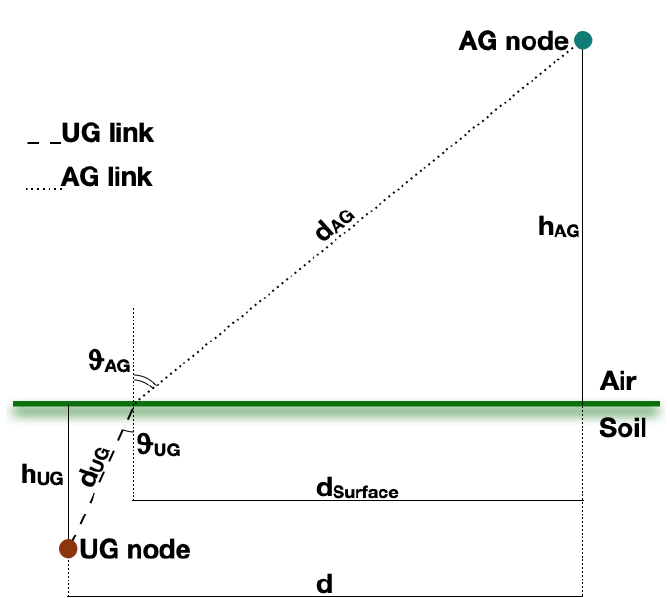
Figure 1. Channel model for UG2AG